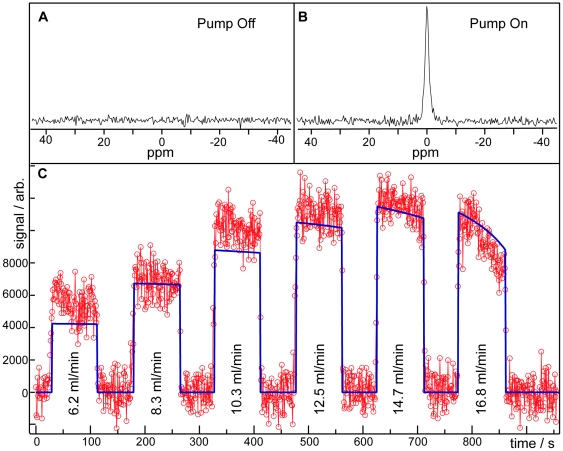
Signal dynamics during EC infusion.
129Xe gas flow through the exchange module was maintained at 10 ml/min throughout the experiment. A. Spectrum acquired at the frequency of 129Xe gas in the absence of EC flow. B.
129Xe spectrum obtained at an EC blood flow of 14.7 ml/min. C. Longtime 129Xe signal dynamics. The red circles depict the gaseous 129Xe signal as a function of time and blood flow through the peristaltic pump. Regions of near-zero signal intensity correspond to periods during which EC flow was suspended. The blue line is a fit of the data to Eq. 7. Regions of zero-flow and 2–5 s transitional periods between turning the pump on and off were omitted in the fit.